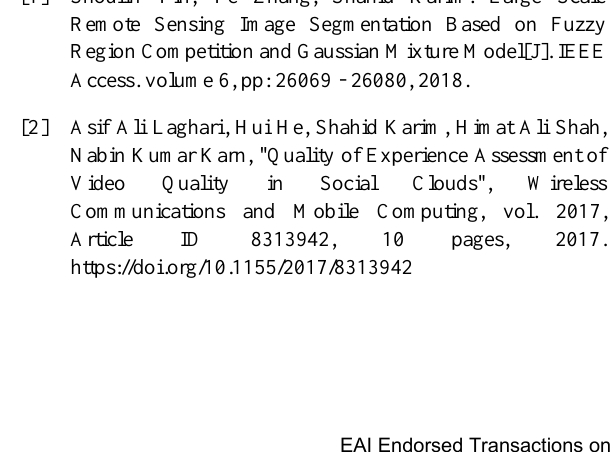
Table 3. Test results of 8 methods on